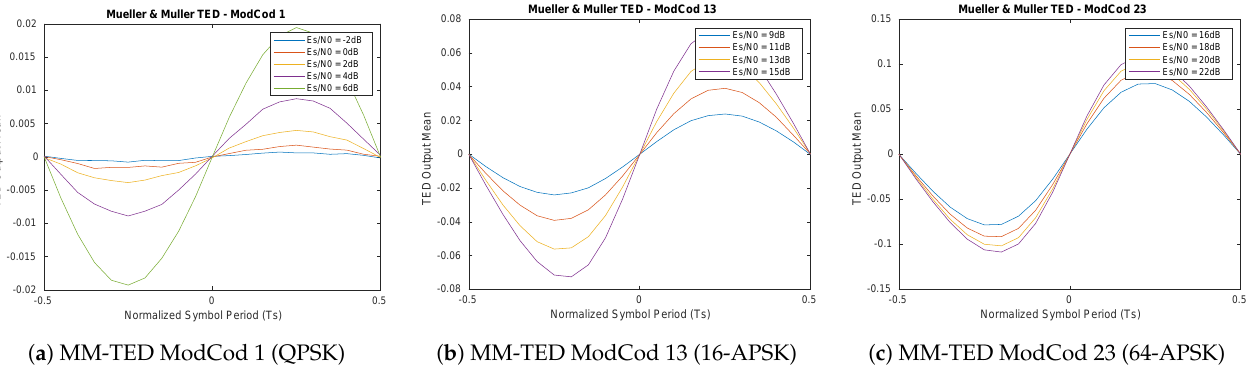
Figure 8. Feedback Mueller and Muller timing estimator S-Curves (500 M